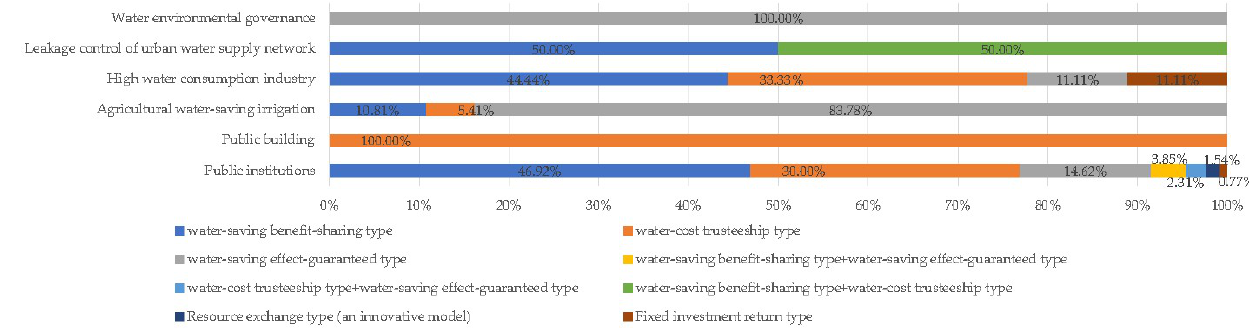
Figure 4. The patterns and proportions of WSMC projects in the various fields.